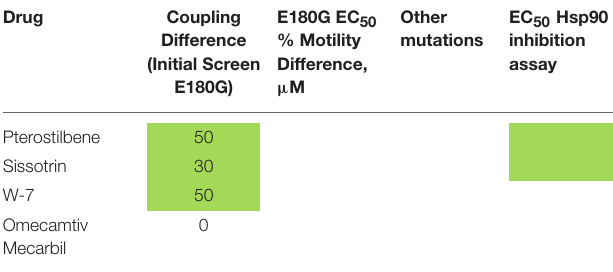
Test system as shown in Figure 2 . Compounds 1–28 were synthesized by Blagg and Khandelwal; their corresponding identification numbers in the original paper are given in brackets and the structures are shown in the supplement (Khandelwal et al., 2013). Difference between motility (%) in phosphorylated and unphosphorylated forms of thin filaments (and EC 50 , when measured) with TPM1 E180G HCM mutation are shown.